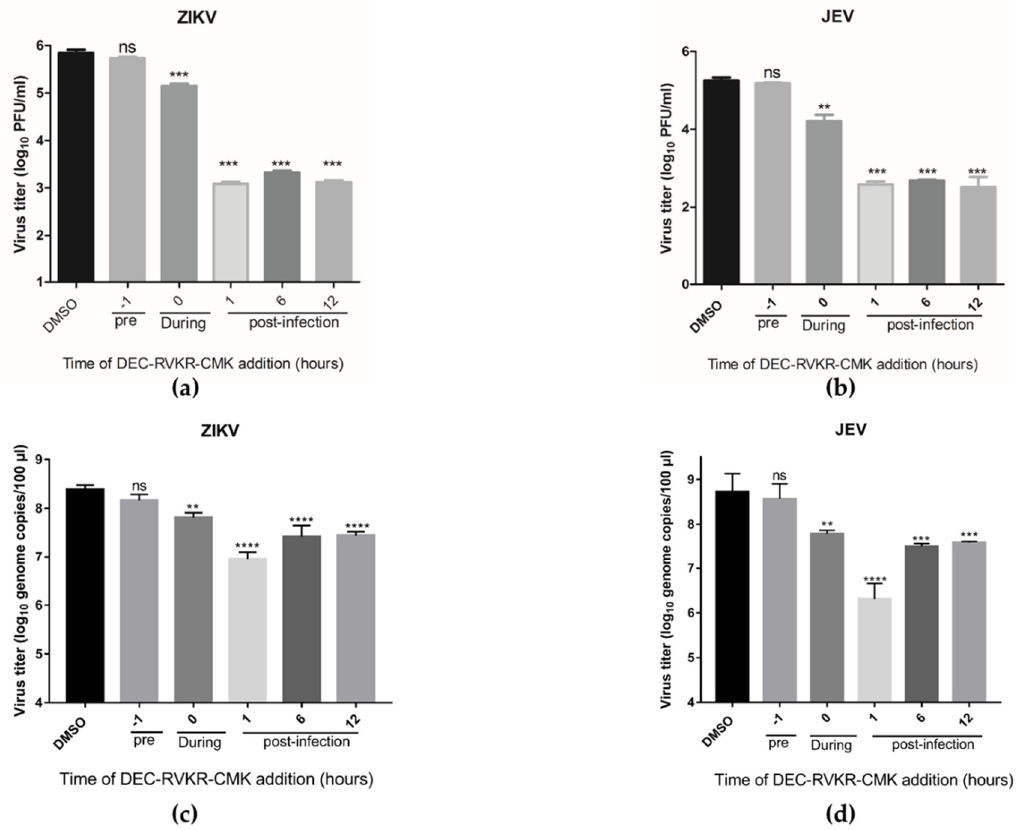
Figure 3. Time-of-addition assay of dec-RVKR-cmk against ZIKV and JEV infection. ZIKV (0.2 MOI) and JEV (0.2 MOI) infected Vero cells were treated with dec-RVKR-cmk (100 µM) at the indicated condition. Time-of-addition study revealed the effect of dec-RVKR-cmk against ( a,c ) ZIKV and ( b,d ) JEV viral titer production and intracellular genome copies, respectively. Data are presented as the mean ± SEM from three independent experiments.